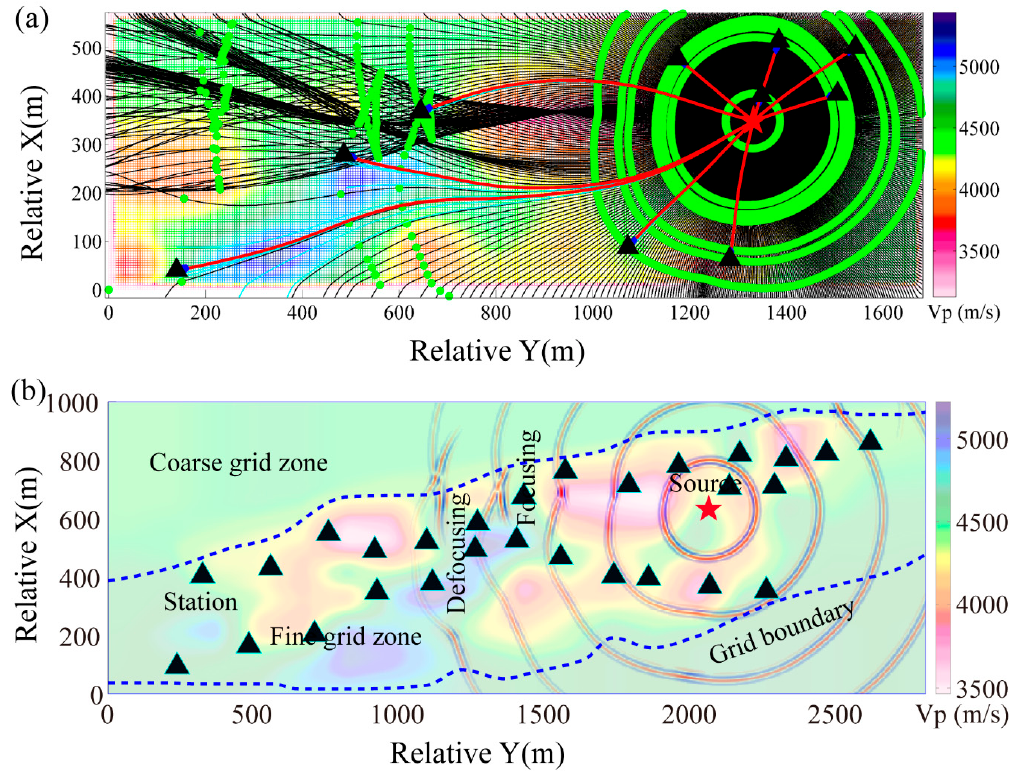
The red fonts correspond to the sensor id, green grid means the ground surface, dark orange line is the Jinyang road, blue lines are di ff erent mining levels, and light blue lines are the mining levels with sensor distributed. The spheres are locations of microseismic events; ( b ) System structure diagram of the MS system modified from Shang et al. [53]. The green line represents 4 core optical fiber, pink line represents 4 core signal cable, and the bold pink line represents 8 core signal cable.